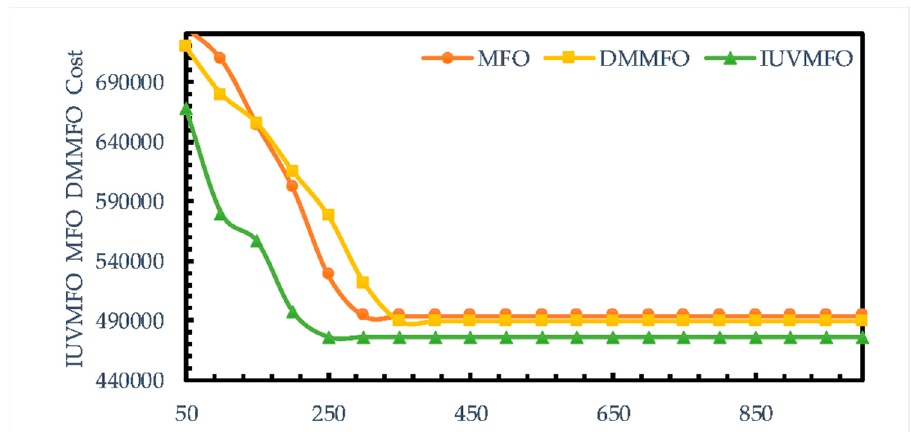
Figure 21. Curve diagram of algorithm test result under weak wind. Table 13. Comparison of results for economic dispatch of cogeneration.